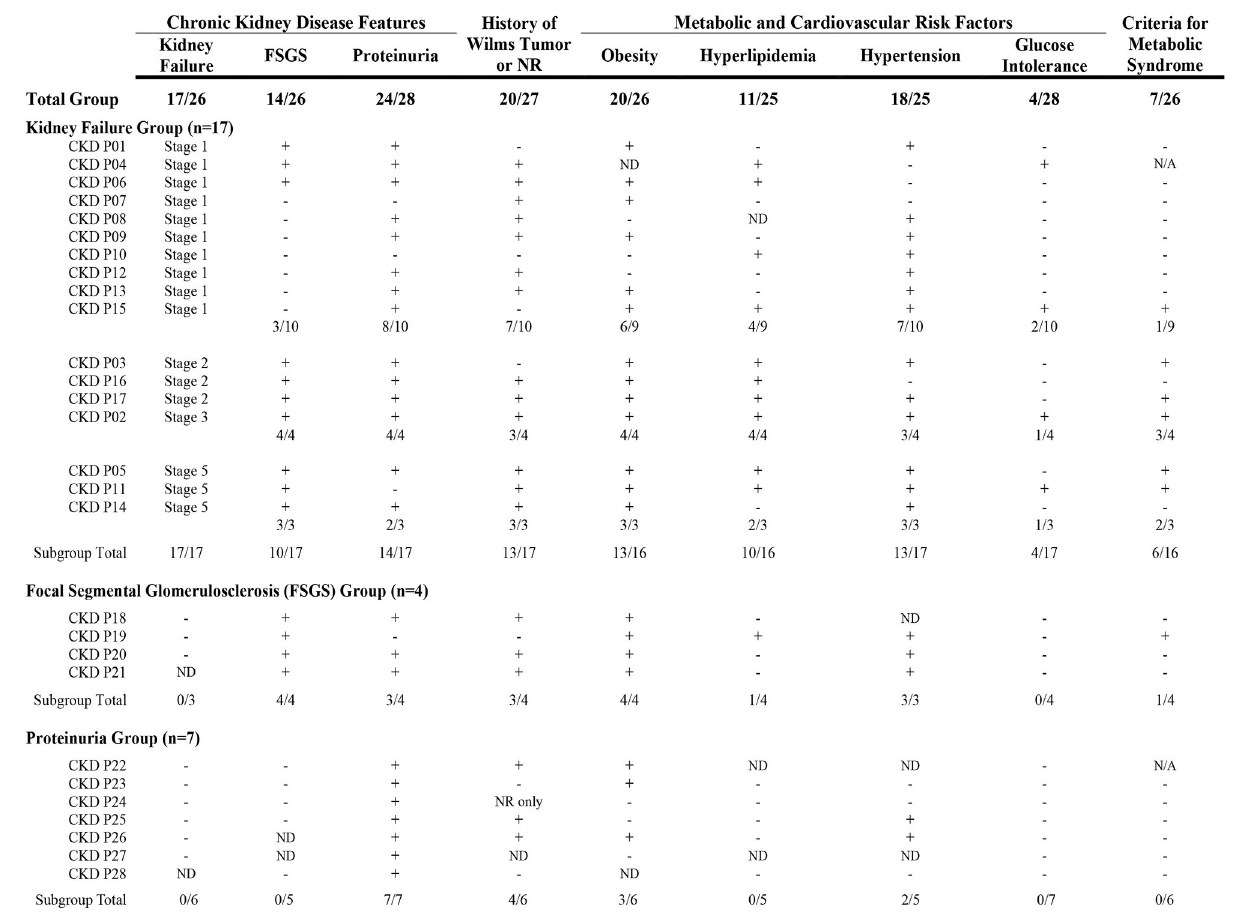
FIGURE 3 | Clinical characteristics reported by participants affected by Chronic Kidney Disease (CKD). A spectrum in the degree of CKD features was observed and included kidney failure, focal segmental glomerulosclerosis (FSGS), and/or proteinuria. Participants are shown in subgroups based on CKD features reported. The presence of clinical characteristics in each participant are shown as: + (affected); –(not affected); or ND (no data). Seven participants did not have a history of Wilms tumor or nephrogenic rest (NR). Cardiometabolic features were common and ∼ 75% of the entire group was affected by obesity and/or hypertension. More than a third of participants in the kidney failure group were affected by criteria for metabolic syndrome [defined as obesity and at least two other features (hyperlipidemia, hypertension, and/or glucose intolerance)]. CKD, chronic kidney disease; FSGS, focal segmental glomerulosclerosis; ND, no data (participant did not provide response to specific question) ; N/A, not applicable (missing data) ; NR, nephrogenic